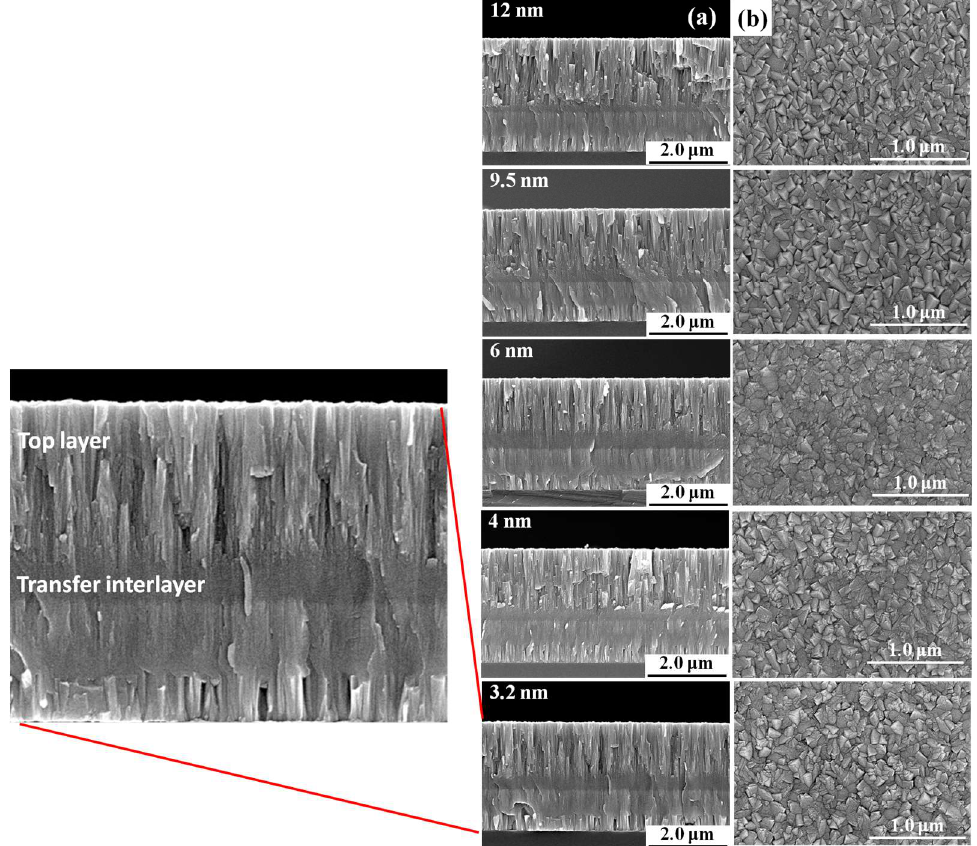
Figure 4. Cross-sectional ( a ) and top-view ( b ) SEM images of bi-layer coatings of various